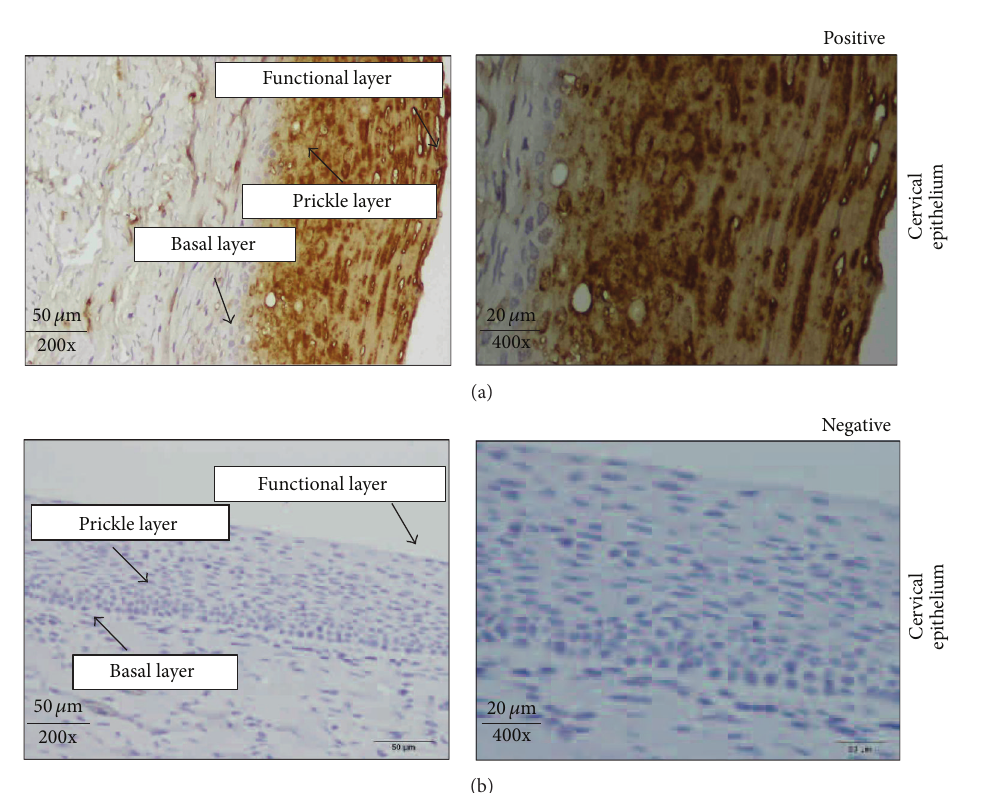
Figure 4: Expression of S100 calcium binding protein A9 in positive and negative controls. (a) Positive controls (normal cervical squamous epithelium) where strong to moderate expression of S100A9 was limited to the differentiated prickle and functional layers with no immunostaining of the regenerative basal layer. Expression of S100A9 was cytoplasmic and nuclear. (b) Negative controls (normal cervical squamous epithelium) without the addition of the anti-S100A9 antibody. All the images were acquired at 200x magnification and 400x. Scale bars = 50 𝜇 m and 20 𝜇